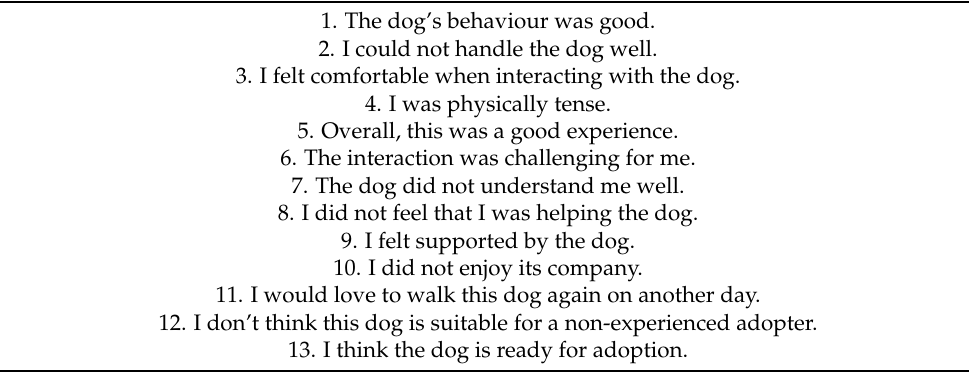
Table 1. Exit questionnaire used for volunteer walkers (reprinted from Shih et al. [49] for convenience).